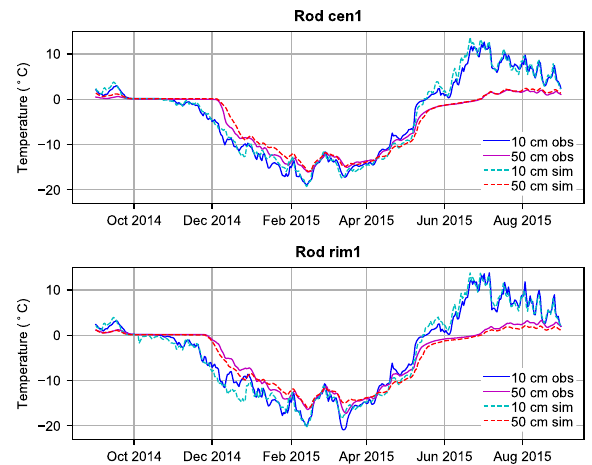
Figure 6. Observed and simulated ground temperature from cali- brated 2-D simulation, at temperature sensor rods cen1 and